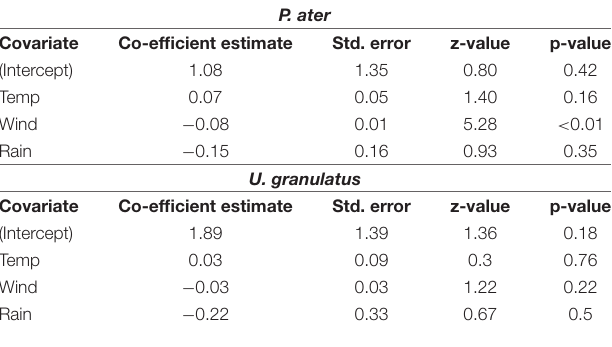
TABLE 3 | Outputs of the Generalized Linear Mixed Models testing whether mean daily air temperatures, wind speeds or precipitation influenced the probability of P. ater and U. granulatus being detected in St. Joseph Atoll on a daily basis.